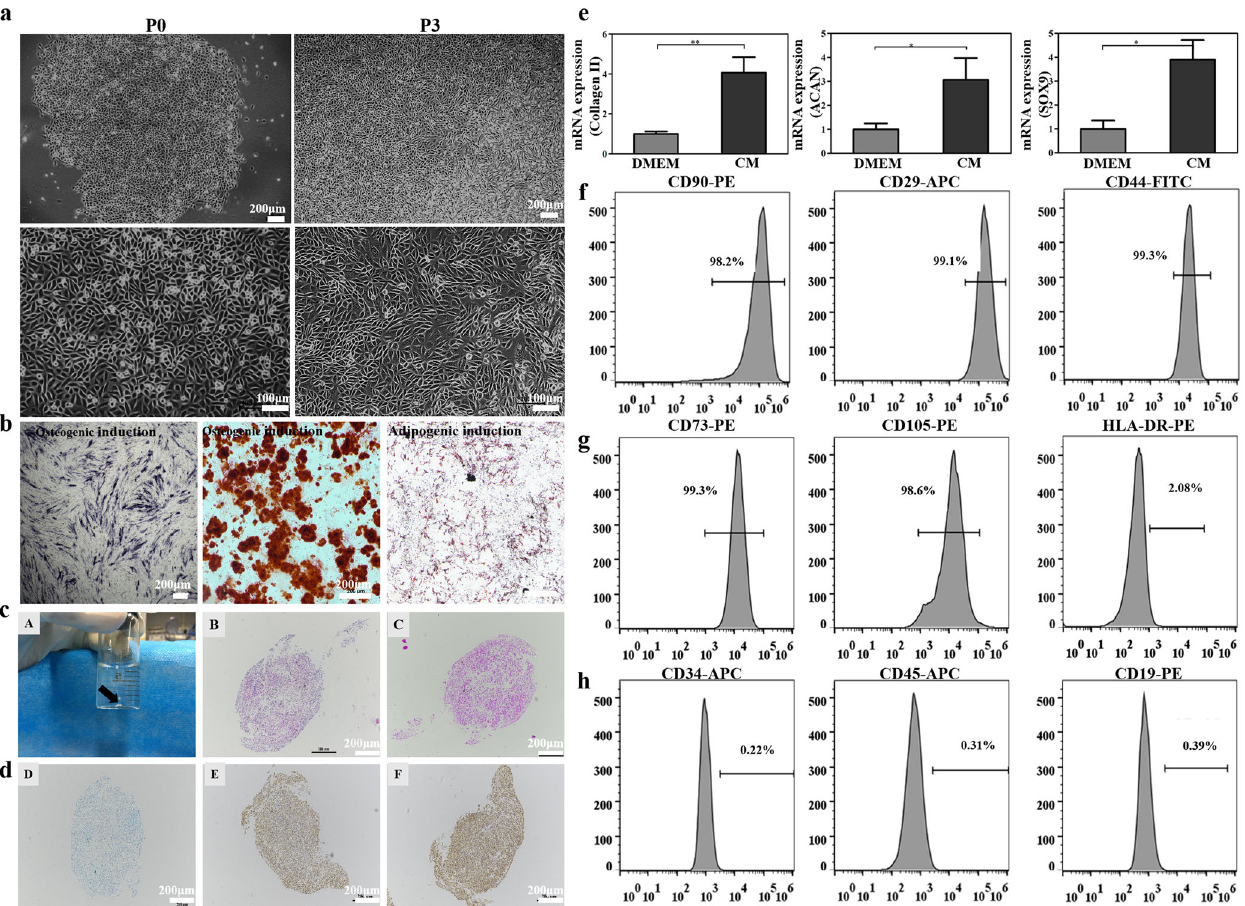
Fig. 2 Characterization of human USCs. a Morphology and proliferation of the USCs. Scale bars = 100 and 200 μ m. b Representative images of osteogenic-induced (by ALP and Alizarin Red staining) and adipogenic-induced (by Oil red O staining) with USCs. Scale bar = 200 μ m. c The potential for chondrogenic differentiation of the USCs after 28 days of 3D chondrogenic differentiation in vitro: (A) Gross appearance; (B) H&E staining; (C) safranin O staining; (D) Alcian blue; (E) aggrecan; (F) collagen II. Scale bar = 200 μ m. e The mRNA expression of chondrogenesis- related genes (Aggrecan, Sox9, and Collagen II) was quanti fi ed in the USCs after 28 days of culture. f – h Expression of surface markers of the USCs. DMEM (standard culture medium); CM (chondrogenic induction medium). ns, not signi fi cant; * P < 0.05, ** P < 0.01, *** P < 0.001, * is the statistical difference compare with DMEM group. One-way ANOVA followed by the Tukey post hoc test was used. Each data point represented an average ± standard deviation, n =